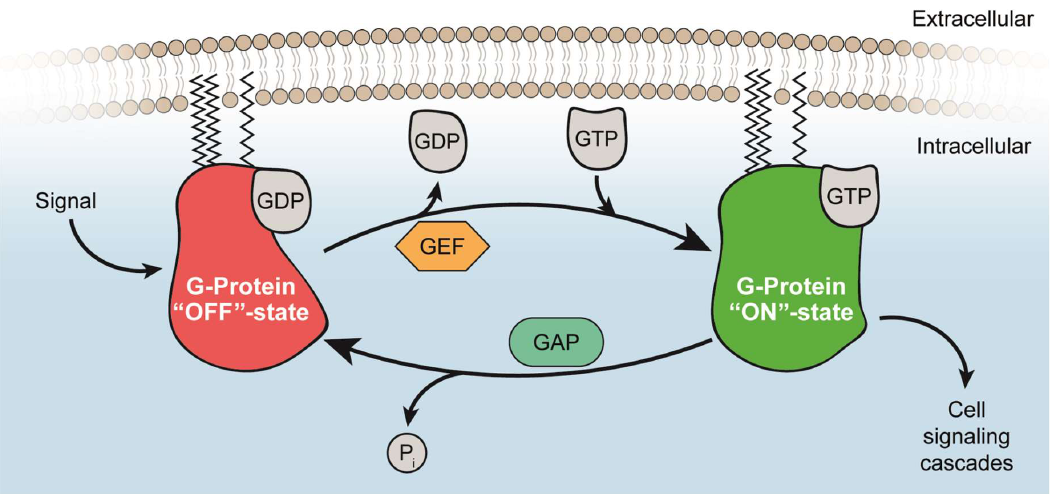
Figure 1. GTPase cycling between GTP-bound “ON” state and GDP-bound “OFF” state. Upon an external signal, a guanine nucleotide exchange factor (GEF) is activating small GTPases (here H-RAS) by exchanging GDP to GTP and thereby modulating cell signaling cascades. To return into the “OFF” state, GTPase-activating proteins (GAPs) accelerate GTP hydrolysis to GDP.